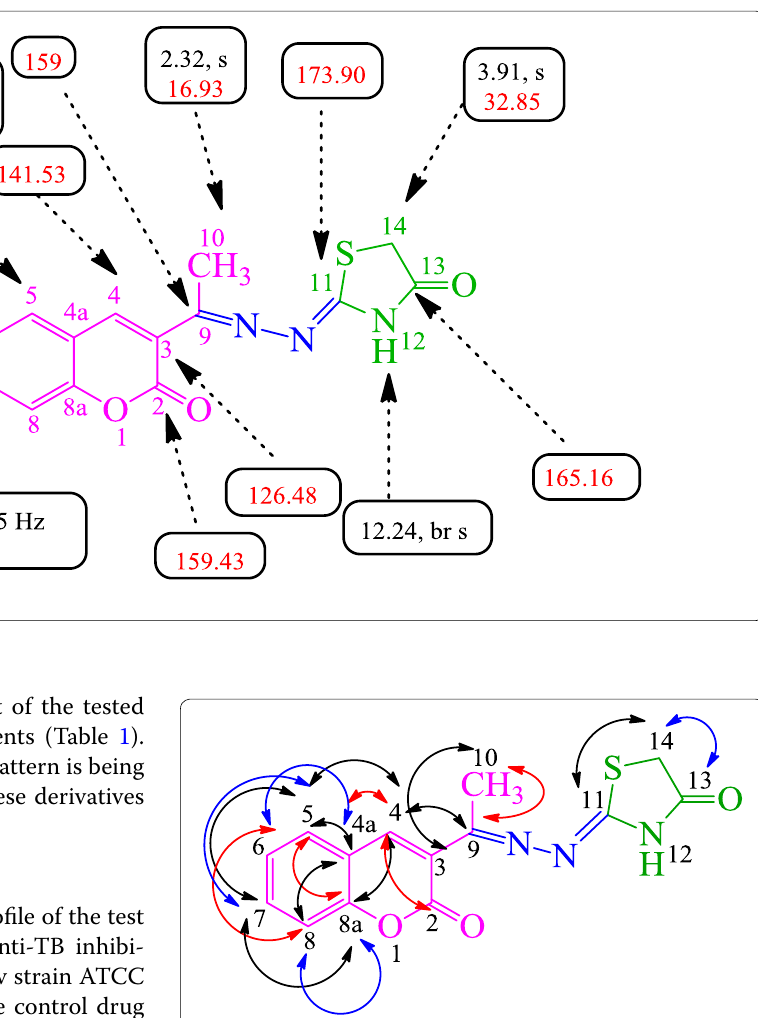
Fig. 4 Possible 1 H and 13 C HMBC correlations of